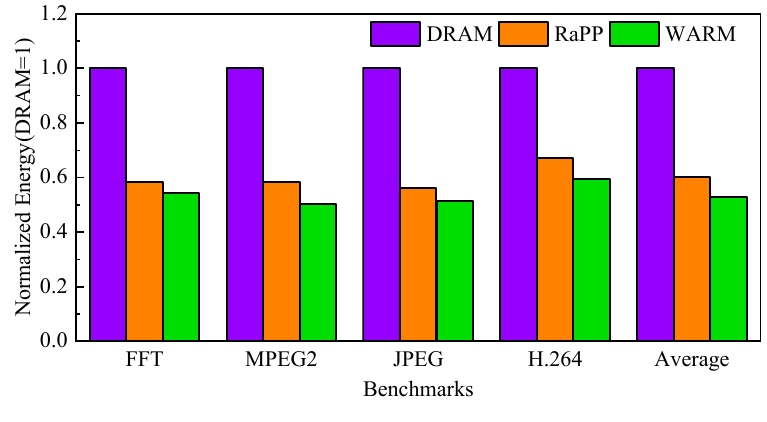
Figure 8. Normalized energy.